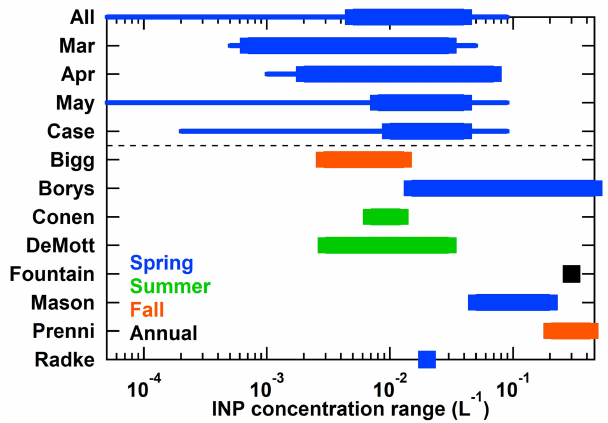
Figure 8. Summary of ranges of atmospheric immersion mode INP concentrations from the current study and those previously reported in the Arctic. Study details can be found in Table 2. For the cur- rent study, “all” and “case” correspond to samples from the entire INPOP study and to the 22–29 May time period, respectively. Addi- tionally, the bars and whiskers represent the range between the min- imum and maximum INP concentrations at the four temperatures in Table 2 per study. Measurements are colored to the season in which they are predominantly collected. The dashed line separates results from the current study from those presented in previous